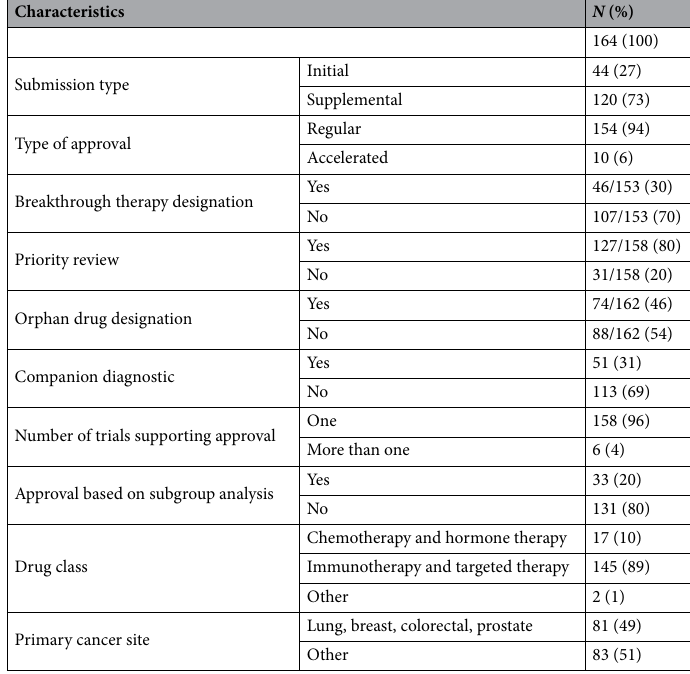
Table 1. Characteristics of applications.